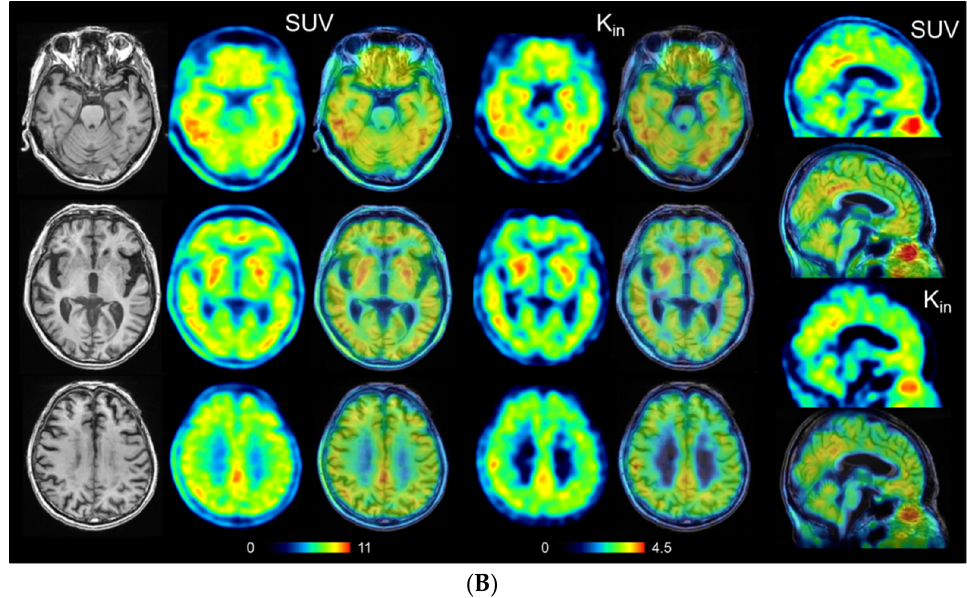
Figure 3. Representative images of HCs ( A ) and eAD ( B ) for SUV and K in (mL/min/100 g) PET image (left) and fusion image (right). The right end column shows sagittal view of SUV (top two rows) and K in (bottom two rows). The left end column shows T1WI-MRI of identical slice location. Note accumulations of the PCC and hippocampus are elevated in eAD patients compared with HCs. A representative whole arterial blood curve obtained from the IDIF and a plasma curve (C p ) corrected for 64 Cu dissociation are shown in Figure 4A. The insert of this graph shows the undissociated rate of 64 Cu-ATSM as a function of time. The radioactivity concentrations of manual blood sampling agreed well with those estimated by the IDIF method. The ratio of octanol extraction to whole blood radioactivity was also consistent with the undissociated rate curve of 64 Cu-ATSM. Figure 4B shows the Patlak plot of a cortical region for the same case. A good linear regression ( r 2 = 0.994) provided a slope representing the K in value for this region. Figure 4C is the result of NLS fitting of the same region to obtain the regional k 3 . The radioactivity curve of brain tissue fitted well to the two-tissue compartment three-parameter model.